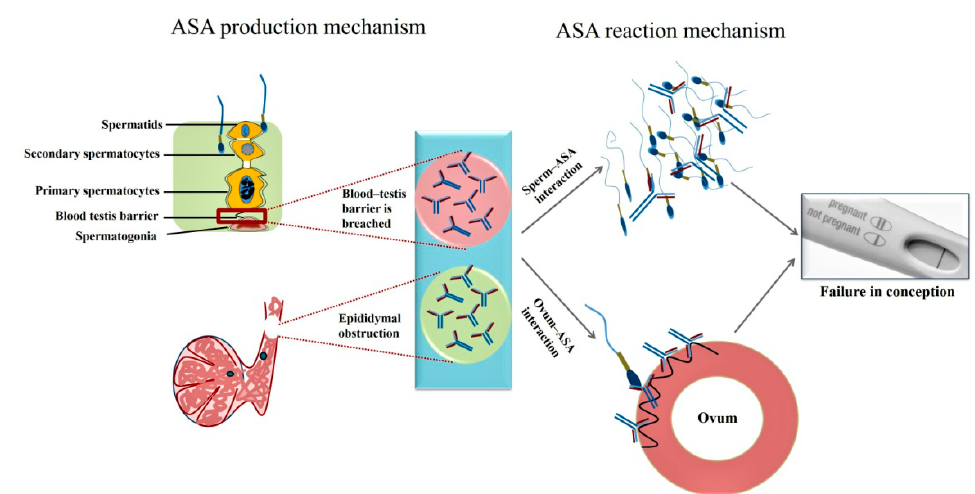
Figure 1. Antisperm antibody (ASA) production by a male and its interaction mechanisms with the female leads to conception failure.